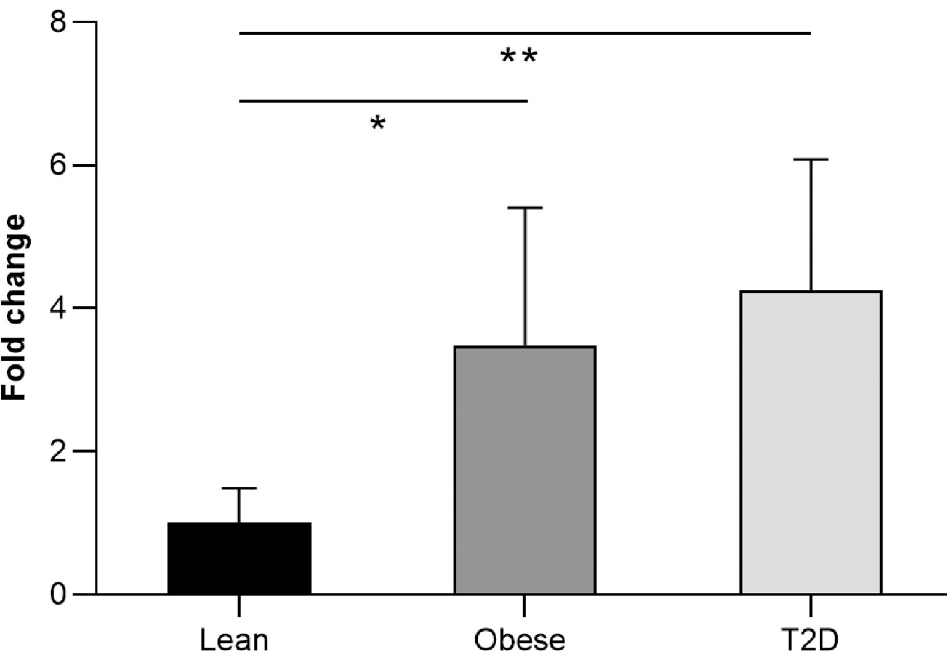
Fig 4. Gene expression of PAI-1 in subcutaneous adipose tissue of lean, obese and T2D normalized against LRP10. ANOVA with Bonferroni’s multiple comparisons test. N = 6 for all groups. Abb. PAI-1: Plasminogen Activator Inhibitor -1; T2D: type 2